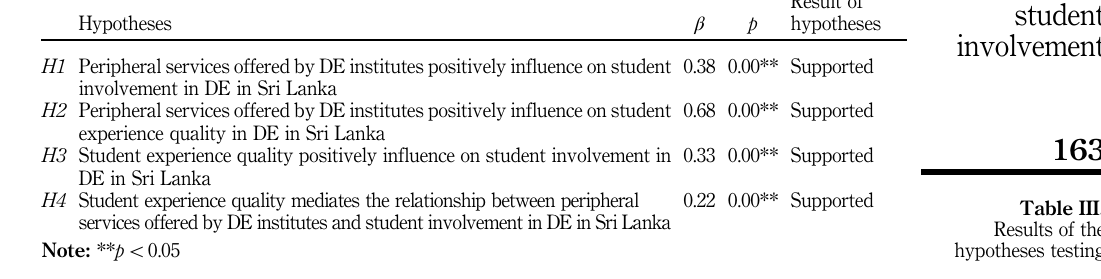
Table III. Results of